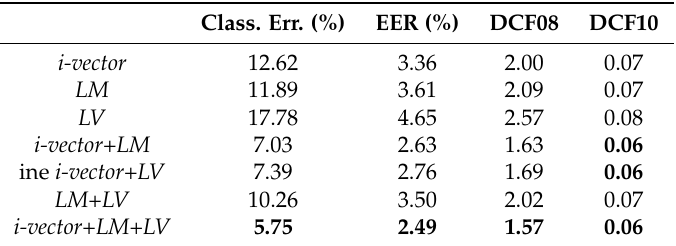
Figure 8. DET curves of the speaker verification experiments using various score-level fusions of the conventional i-vector and the mean and log-variance of the latent variable extracted from the proposed VAE. Table 3. Comparison of results between various score-level fusions of the conventional i-vector and the mean and log-variance of the latent variable extracted from the proposed